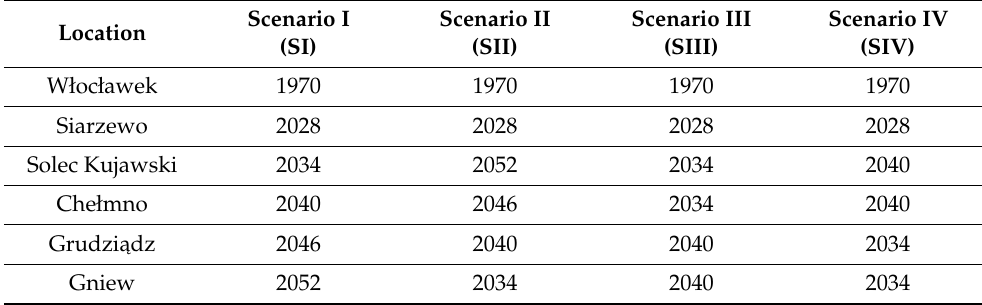
Table 2. Proposed time schedule for barrages